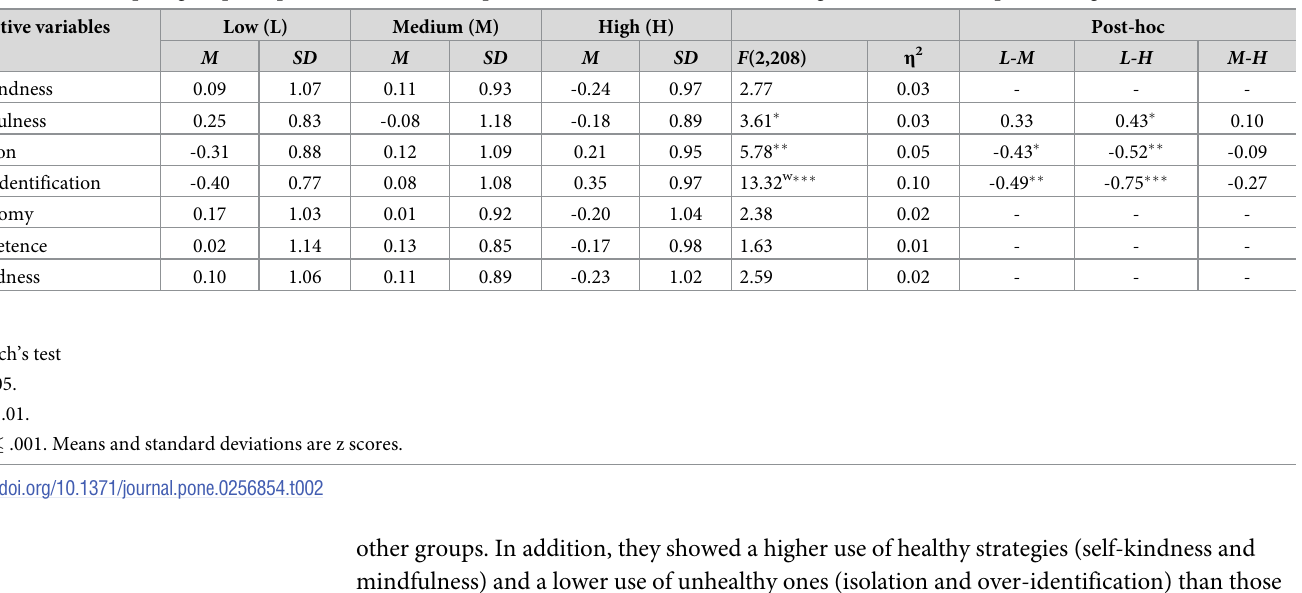
larger than in the other two outcomes.